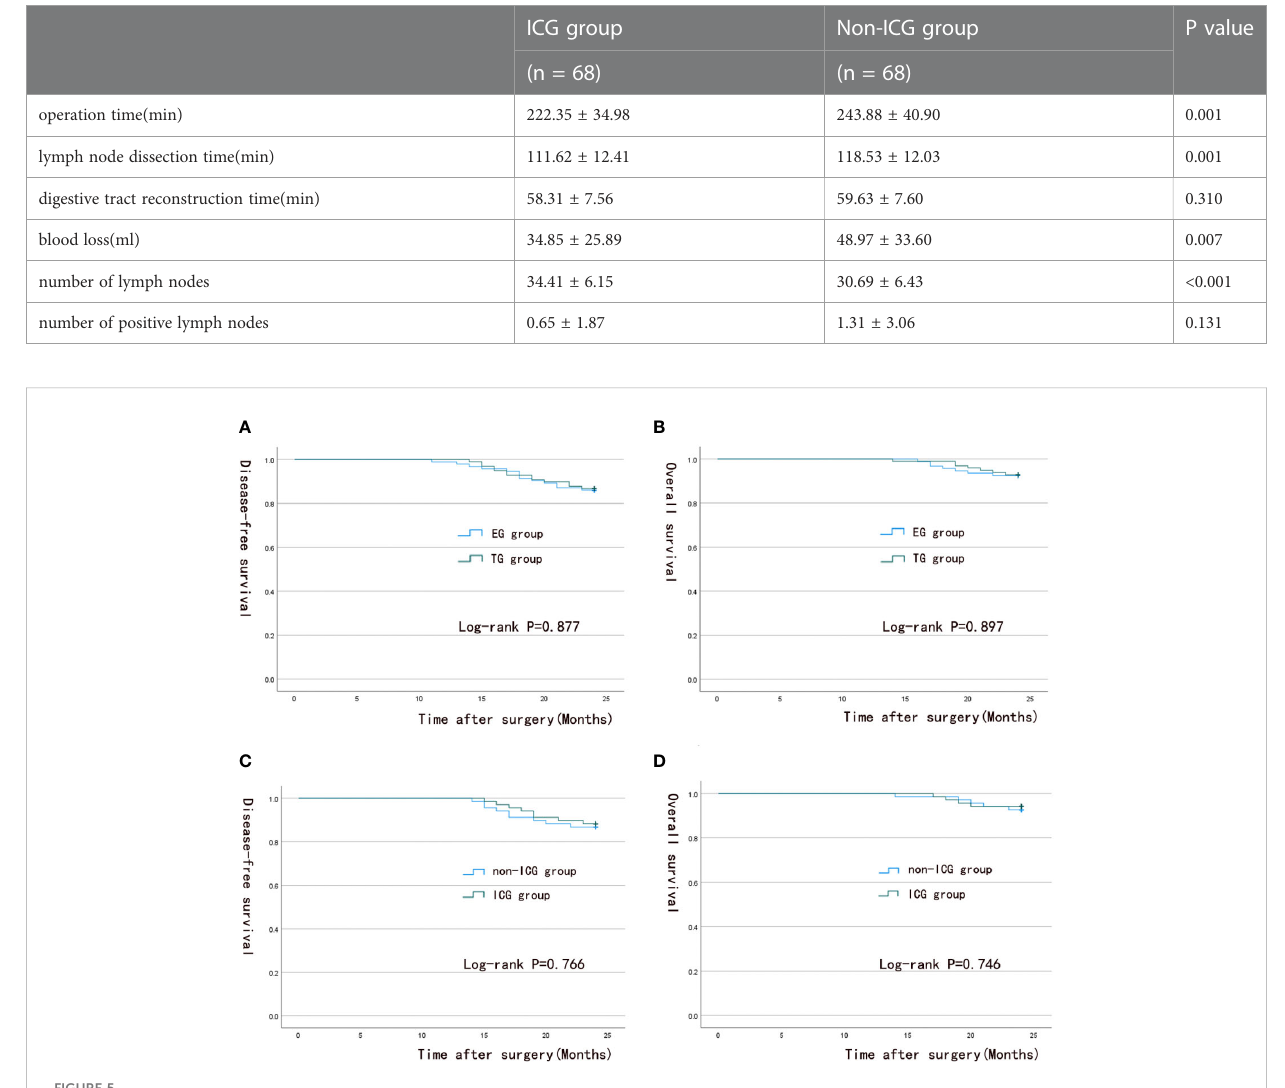
FIGURE 5 Survival analysis curve. (A, B) 2-year overall survival and 2-year disease-free survival in the TG group and EG group; (C, D) 2-year overall survival and 2-year disease-free survival in the ICG group and the non-ICG group.